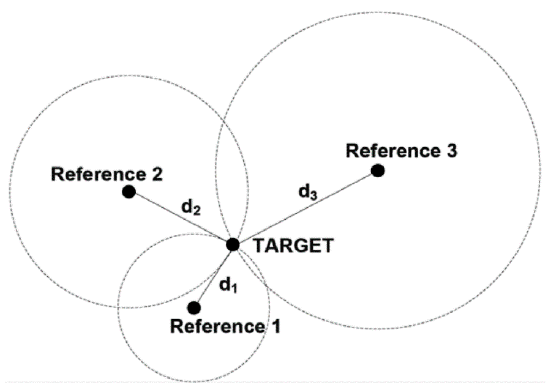
Figure 2. Trilateration process to determine the device position (Reference = antenna; d = distance; TARGET = participant).